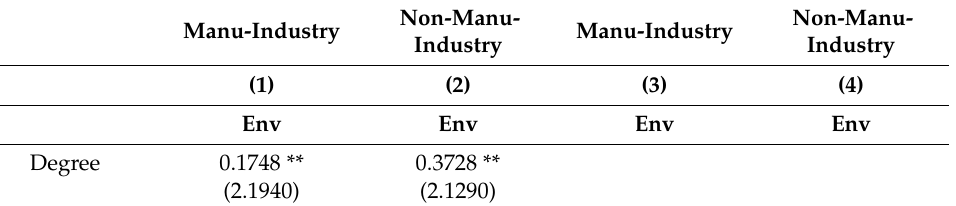
Table 8. Regression results: manu- and non-manu-industry